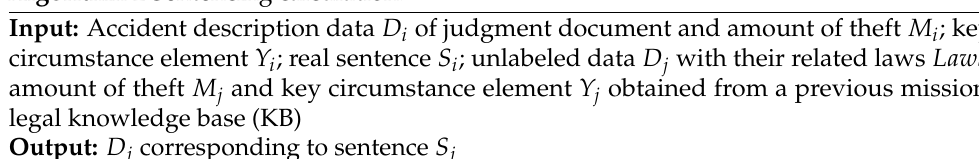
Algorithm 2 Sentencing